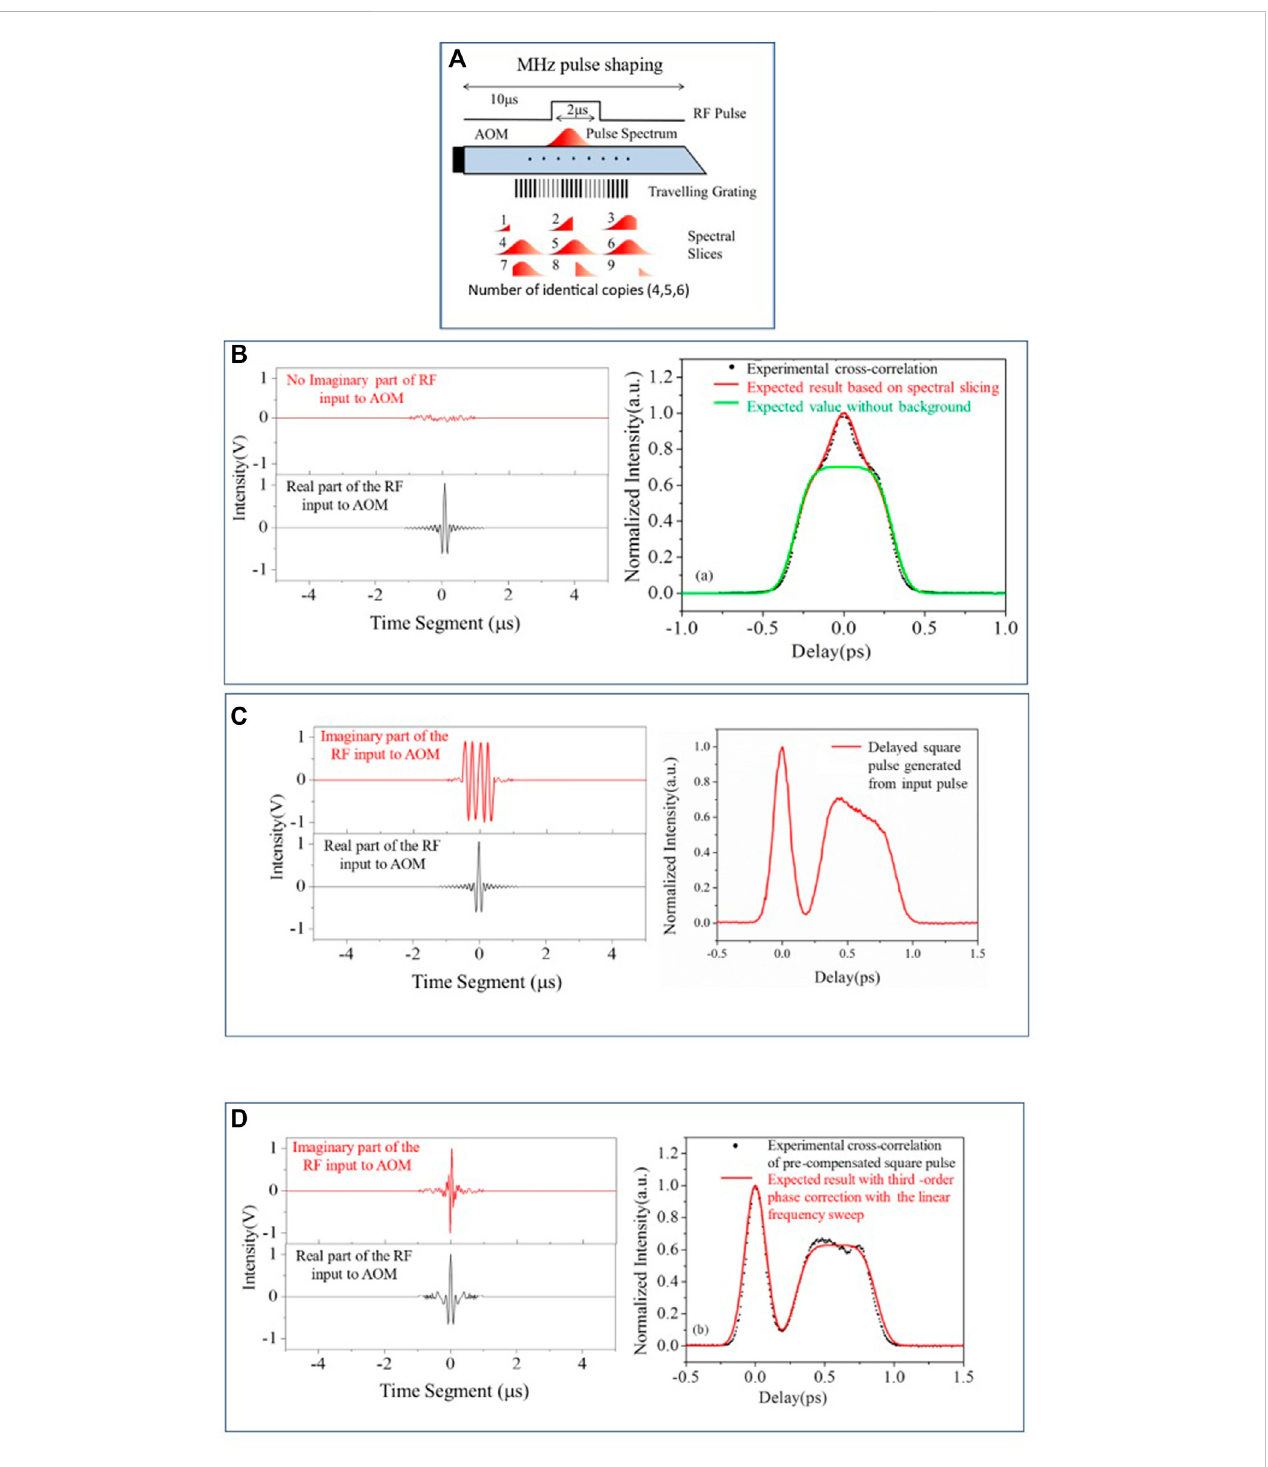
FIGURE 5 Megahertz repetition rate femtosecond pulse shaping: (A) Schematic representation showing that spectral slicing is the key in this MHz pulse shaping scheme in contrast to pulse picking for the low repetition method. (B) Since each pulse at 76 MHz cannot be shaped, there is a background of the original pulses (incident from the laser) in this pulse shaping approach. (C) Application of the Fourier phase provides the requisite time delay to separate the shaped pulses from the unshaped background. (D) Finally, distortion compensation by pre-compensating the RF by adding a third-order phase with the linear frequency sweep, which generates the correct individually shaped square pulses at ~10